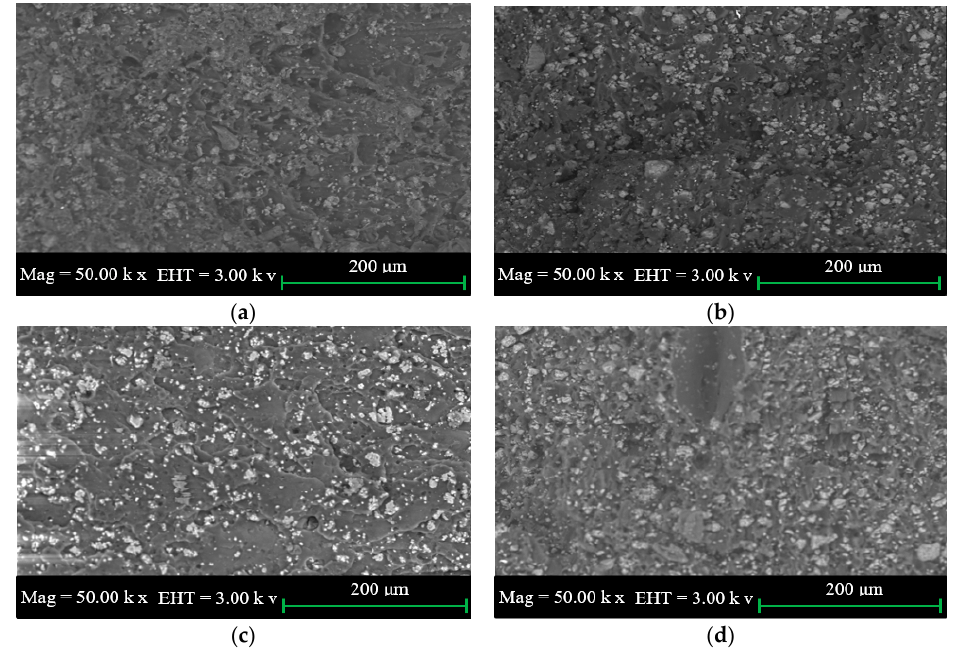
Figure 2. SEM images of the tensile fracture of the polyurethane-starch (PUS) composite at starch wt.% of ( a ) 0.5; ( b ) 1.0; ( c ) 1.5; and ( d ) 2.0.